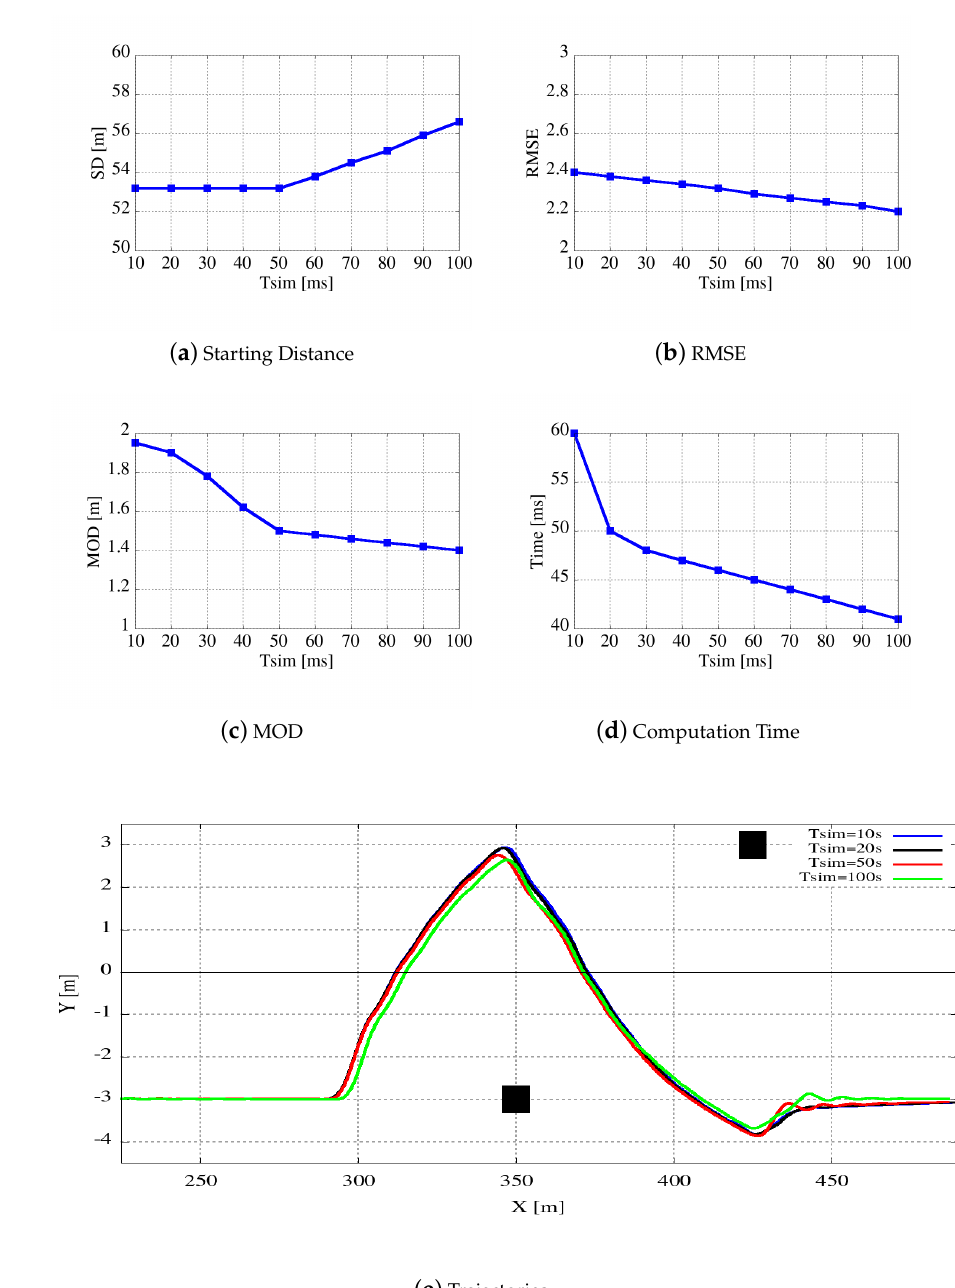
Figure 11. Parameters and paths evaluation for an overtaking maneuver as a function of the height of the T sim parameter varying from 10 ms to 100 ms. Graphs plot the starting distance ( a ), the root mean square error ( b ), the minimum obstacle distance ( c ), and the computation time ( d ). ( e ) shows the reference path and the final trajectories obtained with the different parameters. The car speed is fixed at 25 m/s (90